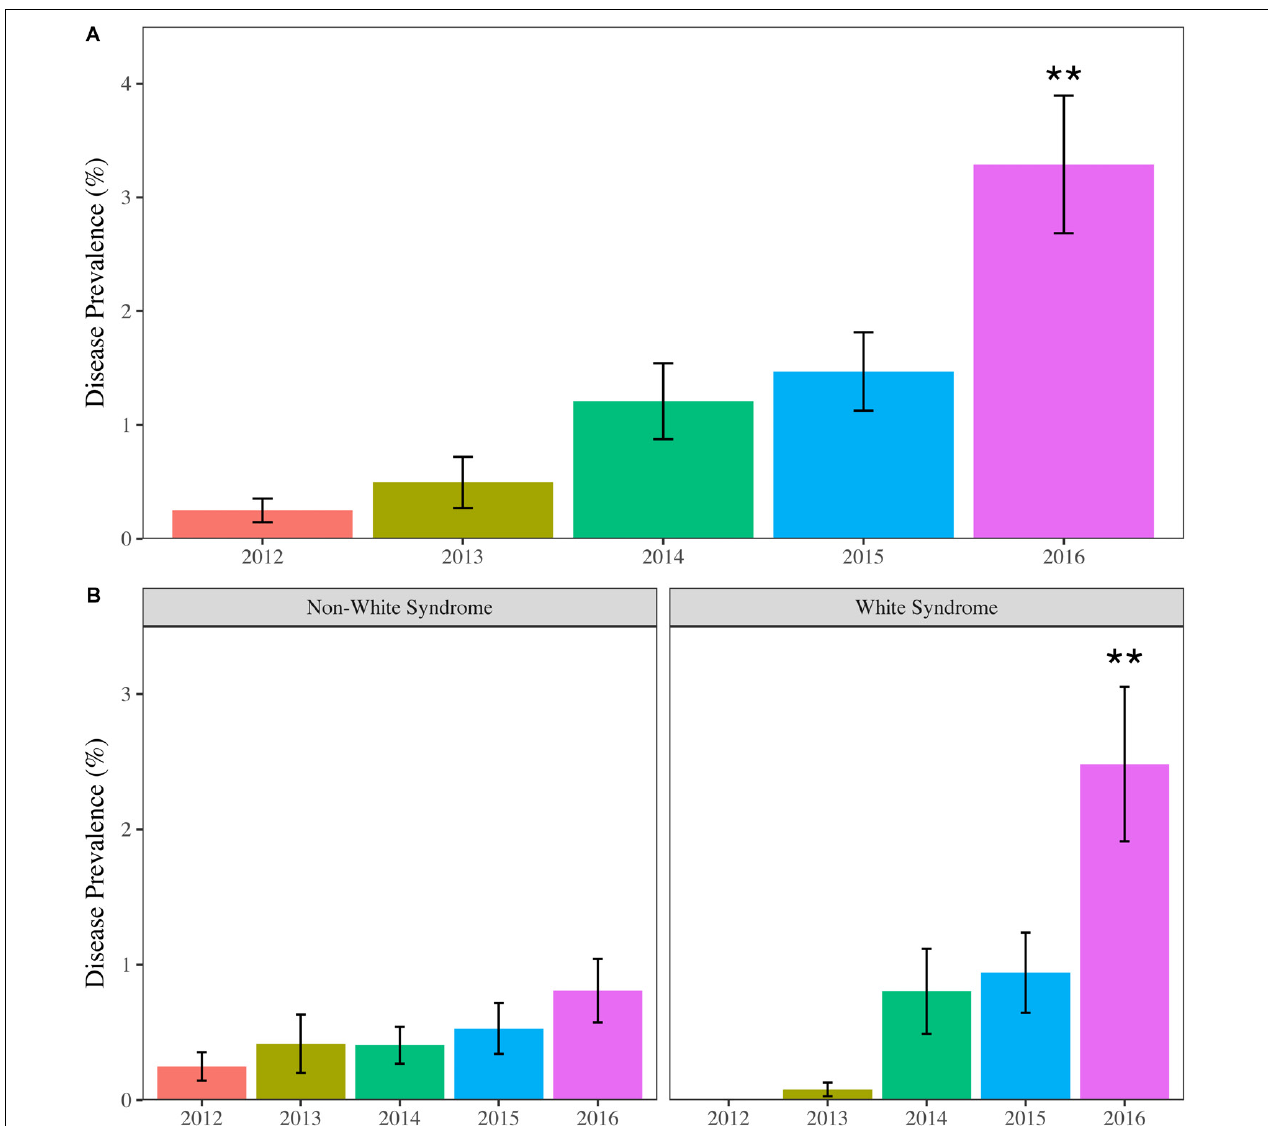
FIGURE 3 | Mean ( ± SE) annual regional coral disease prevalence for (A) all diseases combined and (B) Non-white syndrome and white syndrome. Asterisks indicate years that are significantly different. ∗∗ p < 0.01.